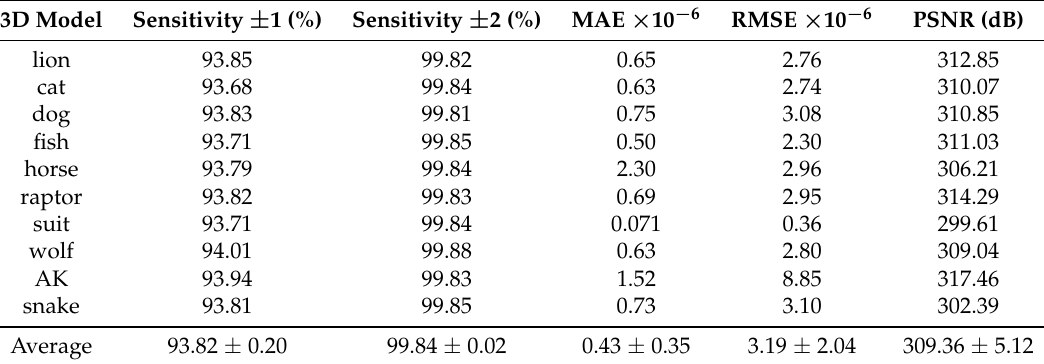
Figure 3. Original models used in the experiments along with [number of vertices]/[number of polygons]composing them: ( a ) lion, ( b ) cat, ( c ) dog, ( d ) fish, ( e ) horse, ( f ) raptor, ( g ) suit, ( h ) wolf, ( i ) AK, and ( j ) snake. Table 3. Performance of the proposed algorithm on a set of ten publicly available 3D